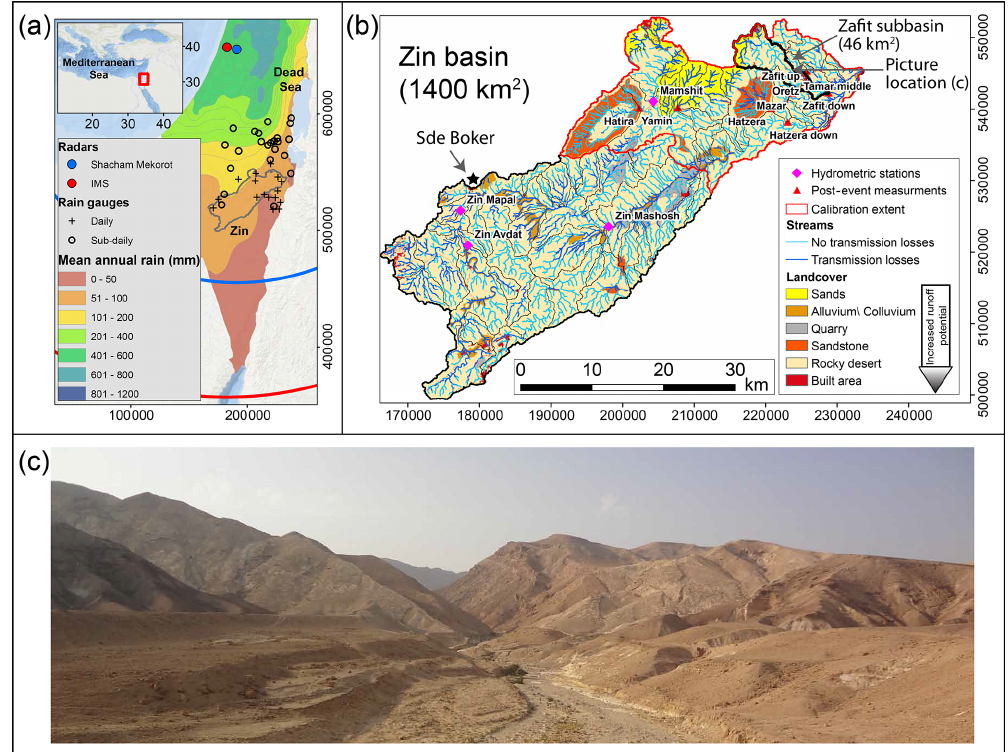
Figure 1. (a) Mean annual rain depth map of Israel (1960–1990, Israel Meteorological Service), daily and sub-daily rain gauges, and the Zin basin location. Extents and locations of the Shacham–Mekorot and the Israel Meteorological Service C-band radars are in blue and red, respectively. Inset in (a) is a general location map. Map coordinates (in m) are of the Israeli Transverse Mercator grid, while for the inset, the geographic coordinate system is used. The World Ocean Basemap by Esri is used as the background. (b) The Zin basin and its 57 subbasins (thin brown lines). The Zafit subbasin is outlined in a bold black line. Hydrometric stations are shown as pink diamonds, and locations of post-event estimations are marked by red triangles. (c) Photograph of Zafit basin taken toward the northwest; the location is marked in panel (b)